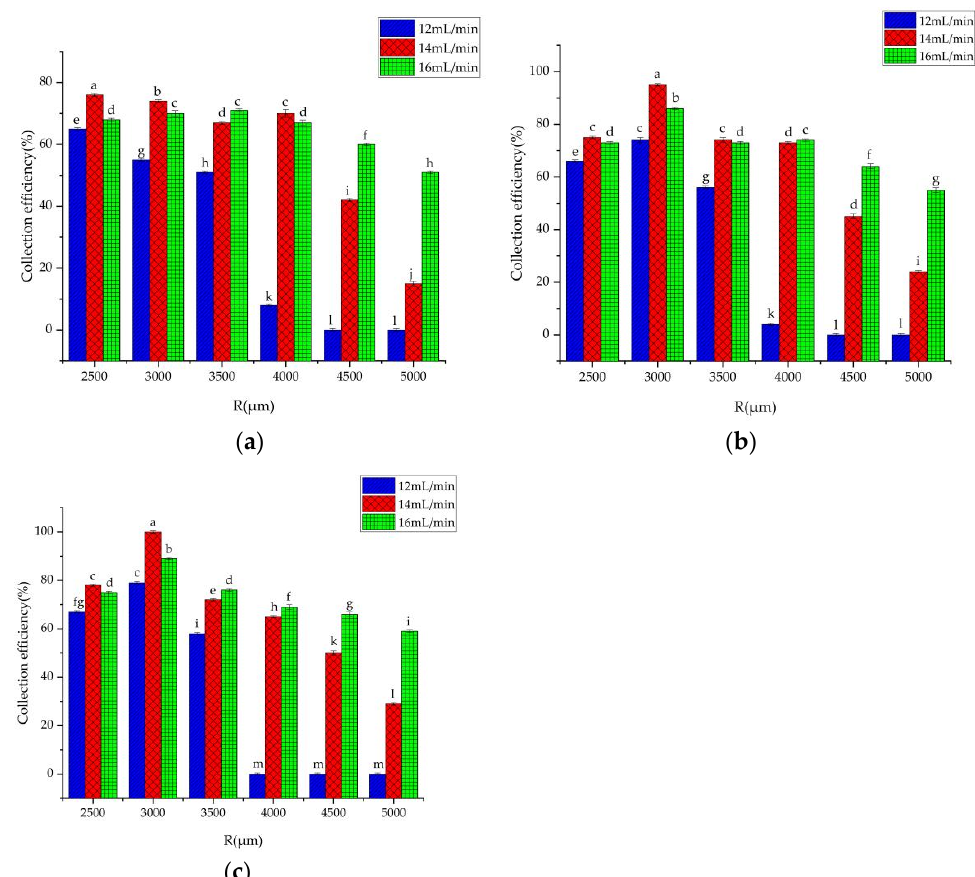
Figure 5. Collection efficiency of 16 μ m particles. ( a ) Spacing of the internal rib structure L = 500 μ m, ( b ) Spacing of the internal rib structure L = 1000 μ m, ( c ) Spacing of the internal rib structure L = 1500 μ m, a, b, and c are used to represent significance levels.